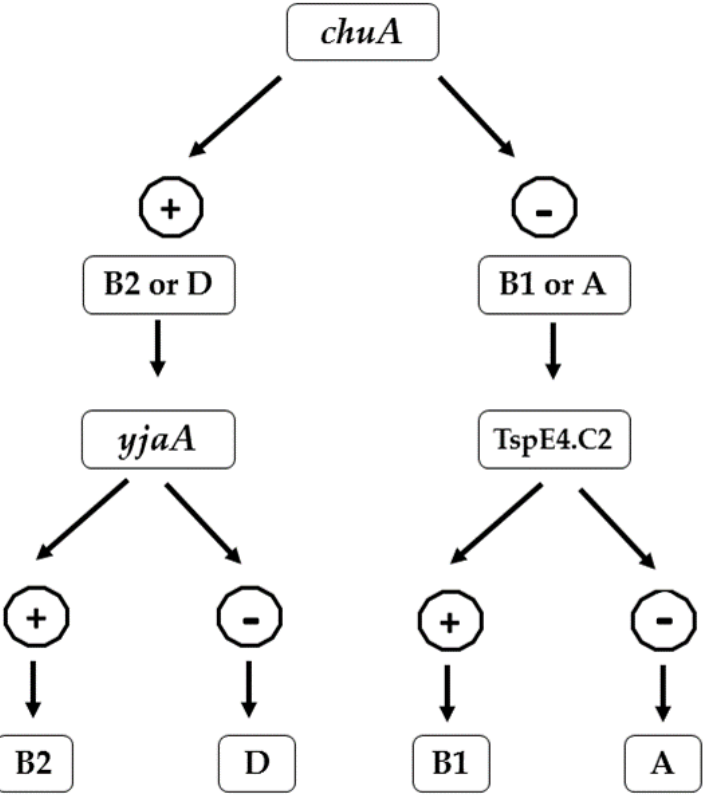
Figure 1. Flowchart showing the scheme of phylogroup determination proposed by Clermont et al. based on the presence and absence of chuA , yjaA, and DNA fragment TSPE4.C2.